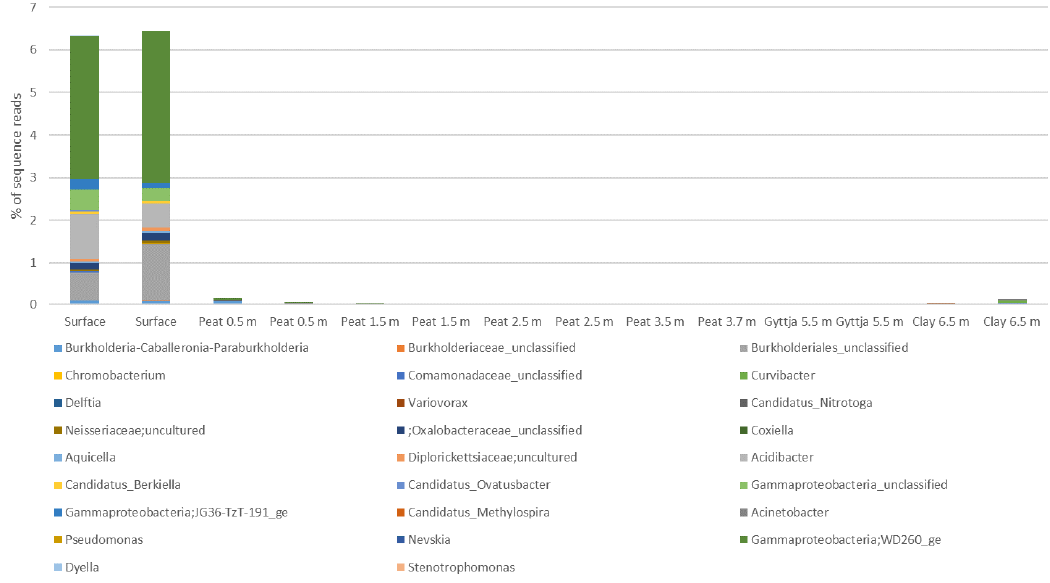
Figure A7. The relative abundance of Chloroflexi genera in Lastensuo Bog samples.